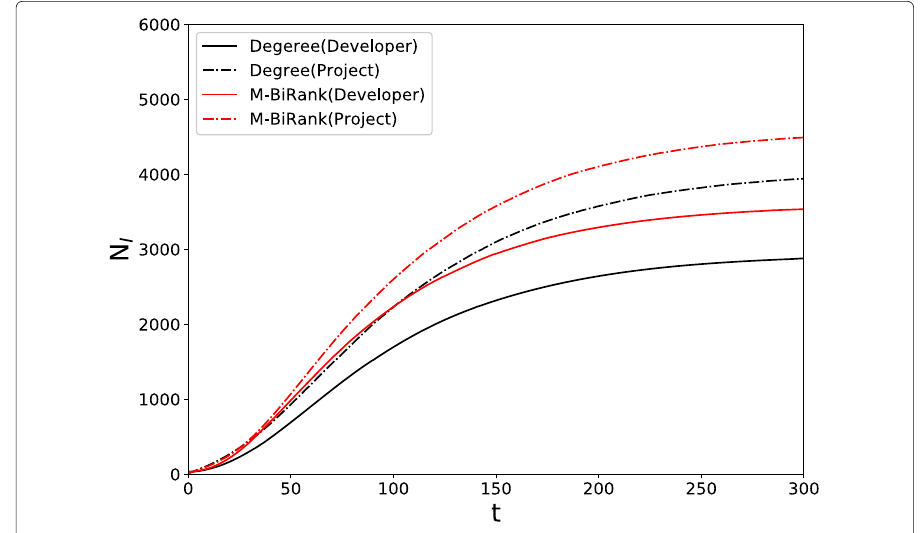
Fig. 4 Performance comparison between M-BiRank and Degree. The horizontal axis t indicates the number of iterations in SIR modeling. The vertical axis N I indicates the number of final infected nodes (developers or projects, including infected and removed nodes)